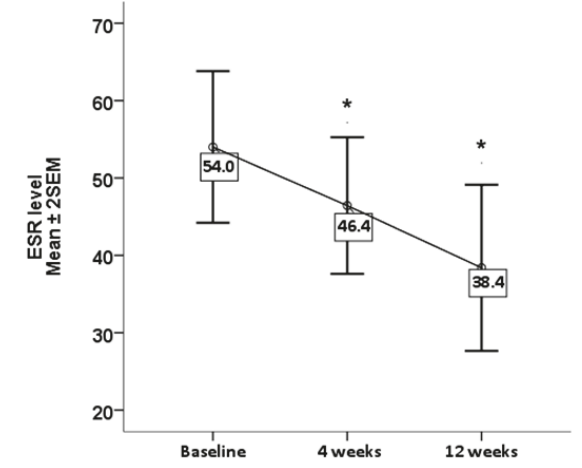
Figure 3: Effect of Gum Arabic intake on ESR Level (P.V=0.011). ∗ indicates significant difference from